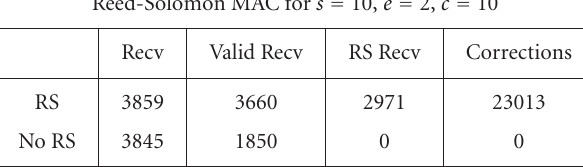
Figure 17: Packets received, Packets correctly received, Reed- Solomon packets received, and number of Reed-Solomon corrected bytes. Averages for 10 trials of 4000 packets